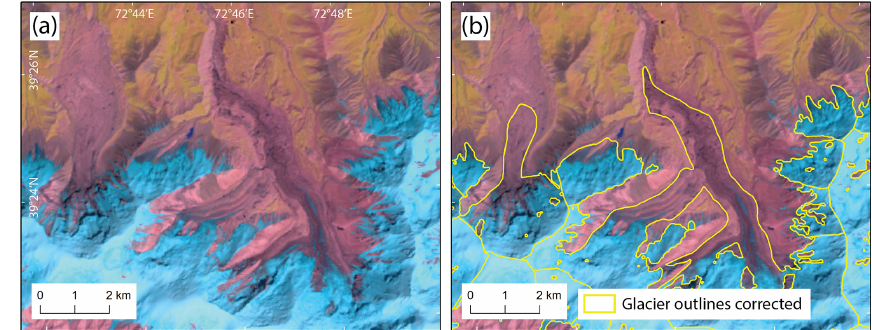
Figure 4. Extensive moraines and large areas of debris can be found on dead ice and active